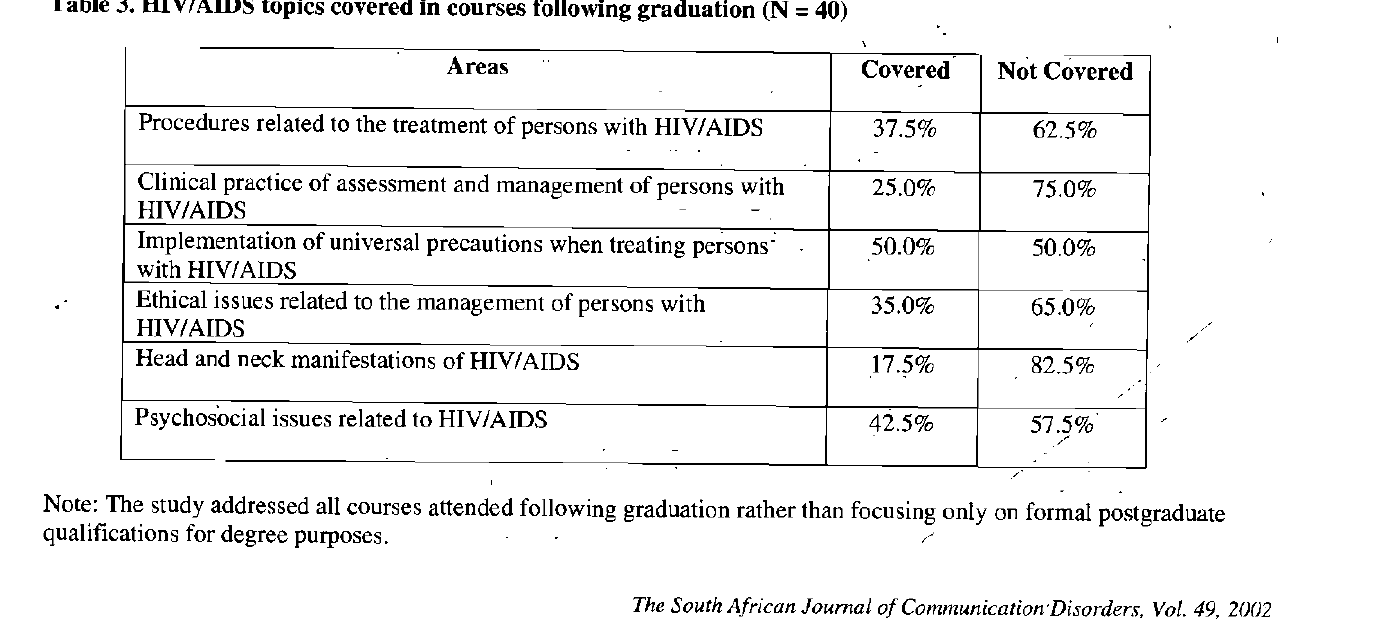
Table 3. HIV/AIDS topics covered in courses following graduation (N =